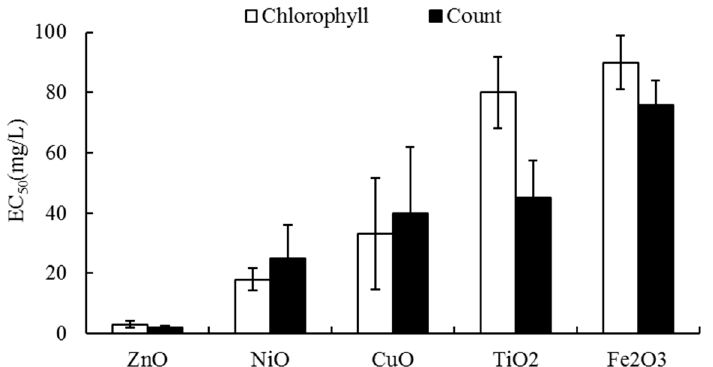
Figure 2. Comparisons of the EC 50s of single NPs in two endpoints of algal growth: the cell count and chlorophyll content. The error bar indicates the 95% confidence level.